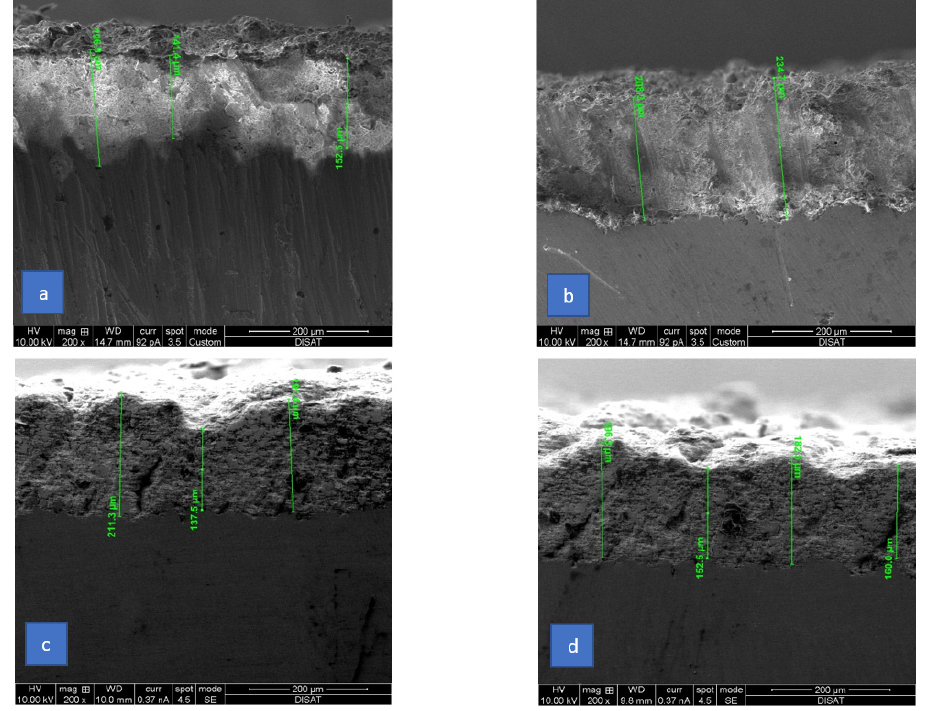
Figure 6. SEM images: ( a , b ) APS samples; ( c , d ) SPS samples.